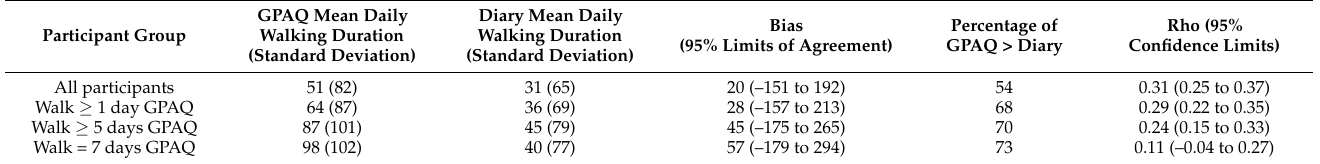
Table 6. Comparison of daily walking duration (minutes) between GPAQ and travel